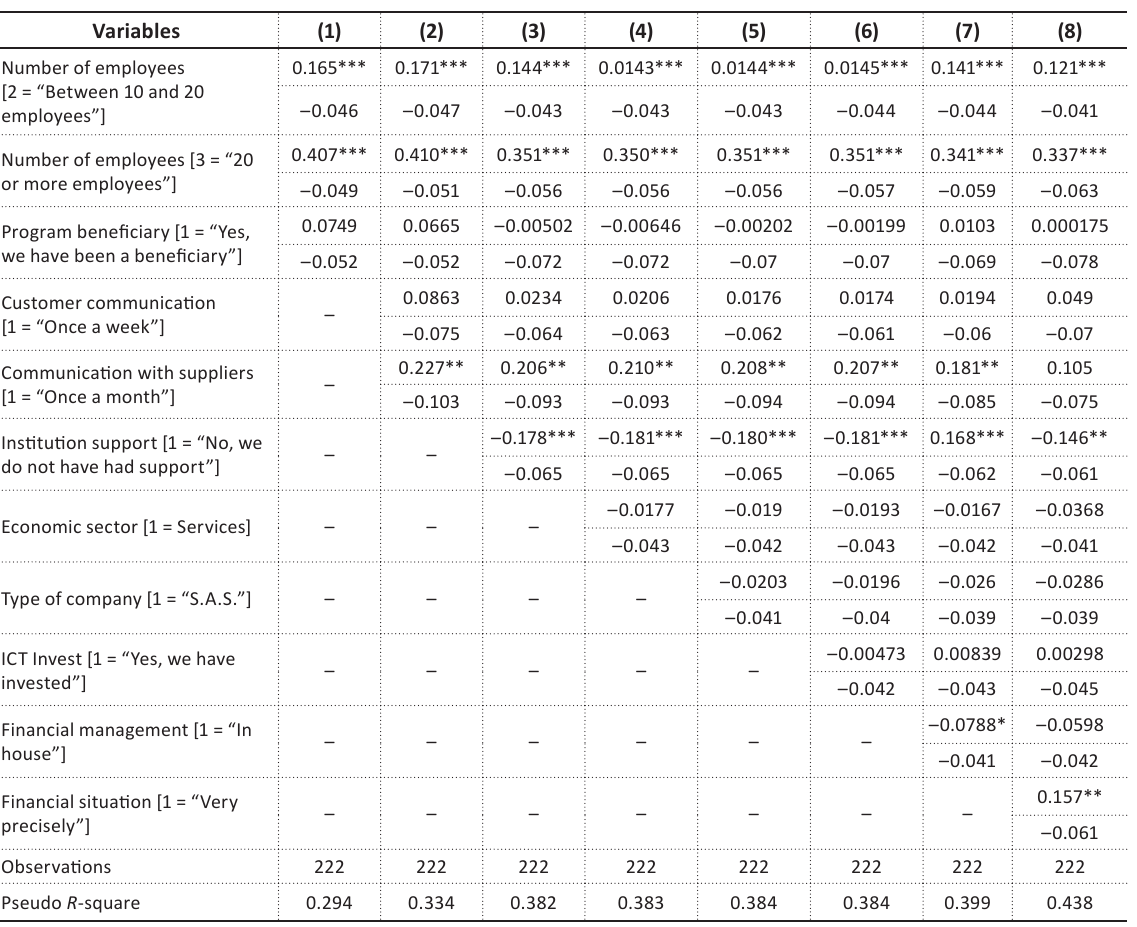
Table 5. Results of the econometric